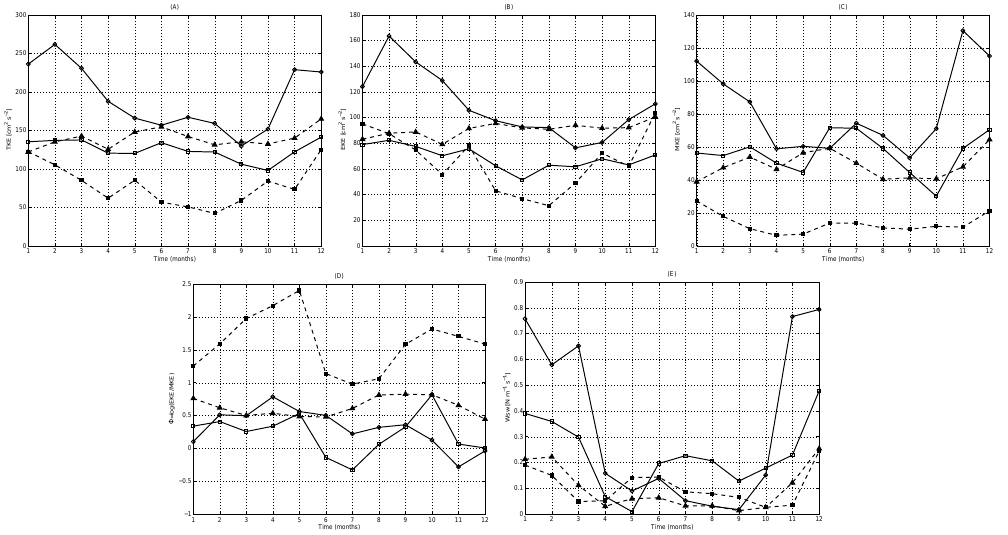
Fig. 5. Time series of: TKE (A), EKE (B), MKE (C), Φ (D), Wsw (E); all time series have been averaged for the Sardinia-Tyrrhenian sub-region (continous-line, empty circle), Sicily sub-region (continuos-line, empty square), Tunisian sub-region (dashed-line, full square), Lybian sub-region (dashed-line, full trian- gle), vertically integrated from surface to 5m depth and on the period 2008-2010.